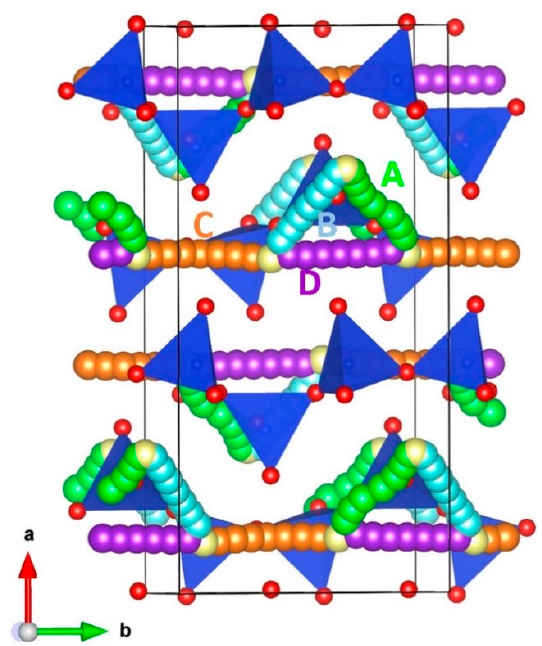
Figure 3. Long-range Ca vacancy migration paths considered. Green, light blue, orange and purple atoms show the Ca ion movement in different local Ca hops. Table 3. Activation energies calculated for local Ca hops.